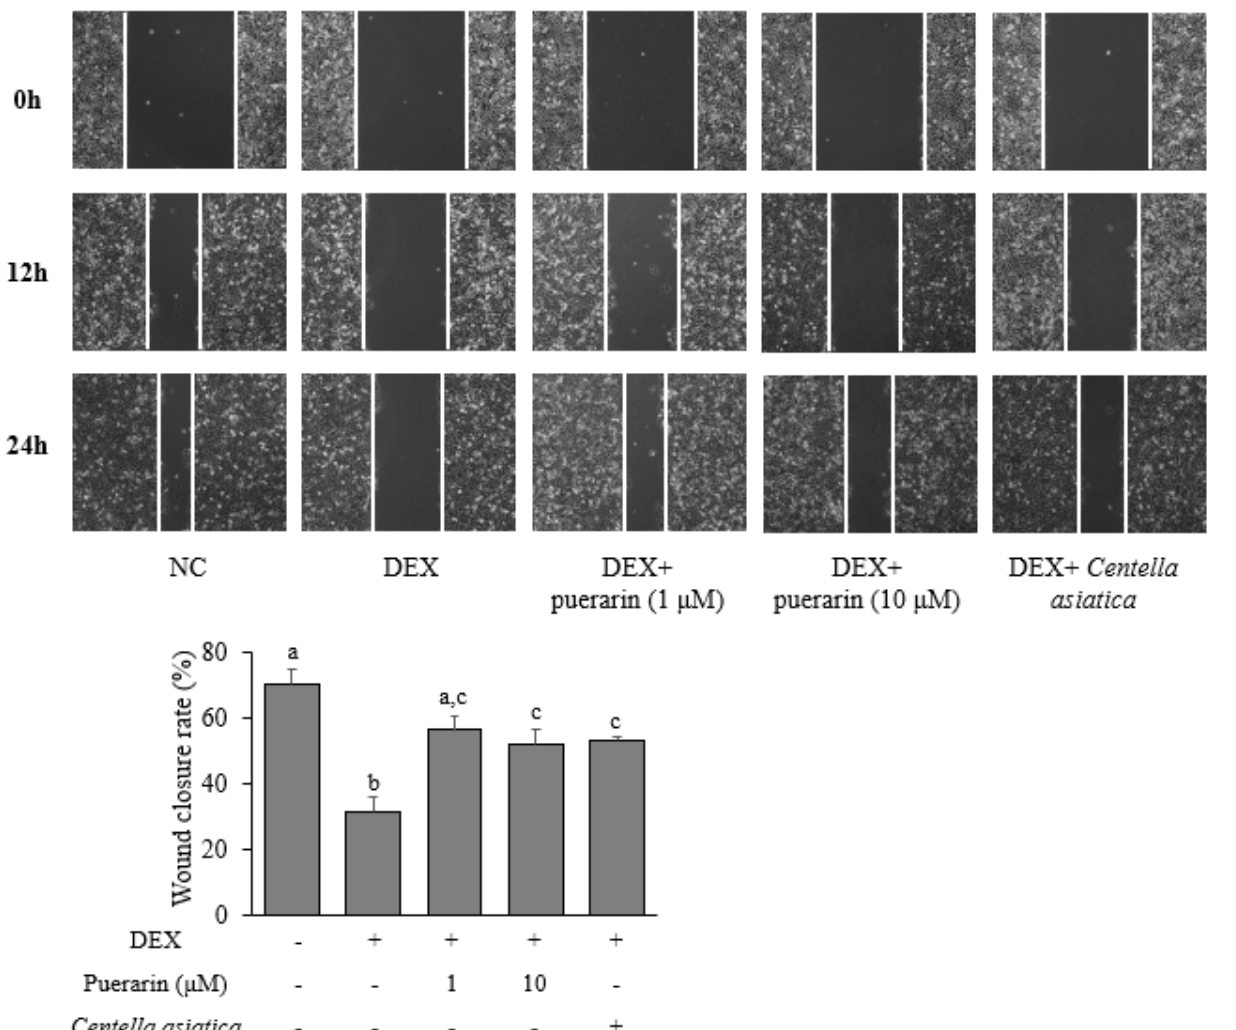
Figure 3. Effects of puerarin on cell migration in HaCaT cells stimulated with DEX. The HaCaT cells were incubated with DEX (100 nM) and puerarin (1, 10 μ M) or Centella asiatica extract (100 μ g/mL). Before the scratch wound was made, the cells were treated with mitomycin C (10 μ g/mL) for 1 h to inhibit cell proliferation. The images of the scratch gap width were captured at 0, 12, and 24 h post-scratching. The wound closure rates were defined as the difference between the wound width at 0 and 24 h. The results are presented as the means ± SDs of three independent experiments. Bars labeled by the same letter on the graph are not significantly different from each other ( p < 0.05) by one-way ANOVA followed by post hoc Tukey’s test.